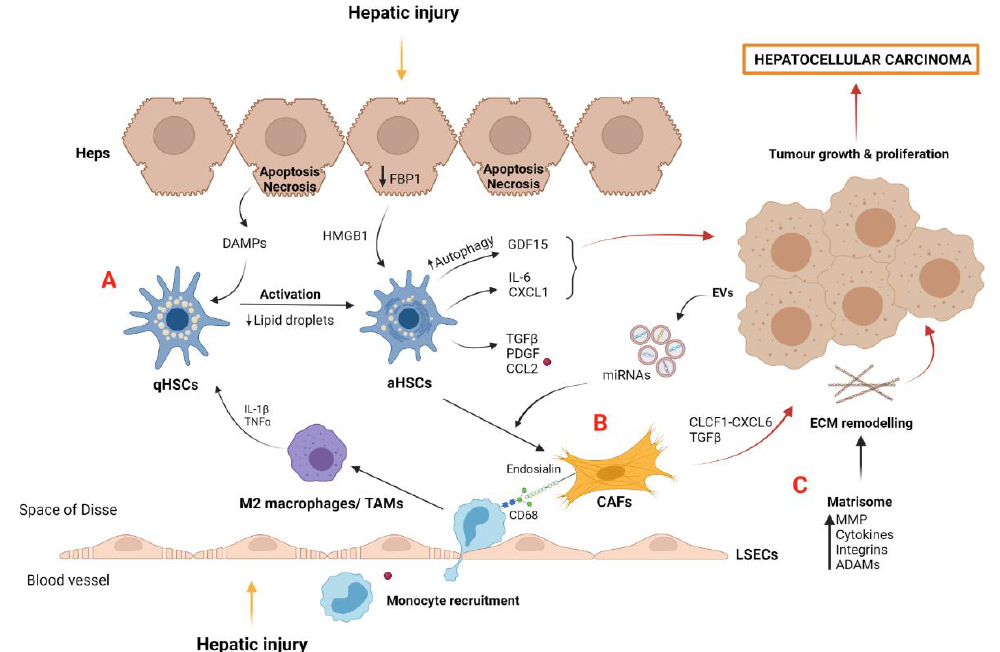
Figure 3. Myofibroblast-derived cells and matrisome contribution to tumor microenvironment and HCC development: ( A ) Quiescent HSCs become activated by DAMPs released by apoptotic hepatocytes and by IL-1 β and TNF α secreted by polarized M2 macrophages after hepatic injury. aHSCs induce the secretion of proinflammatory growth factors and chemokines such as CCL2, which is recognized by macrophage CCR2, perpetuating liver damage and tumor growth. aHSCs, induced by the loss of hepatocyte FBP1, secrete cytokines such as IL-6 and CXCL1, which are involved in liver tumorigenesis. Growth factor GDF15, induced by aHSC autophagy, also contributes to hepatocarcinoma. ( B ) CAFs are derived from activated myofibroblasts such as aHSCs. Diverse growth factors and miRNAs contained in EVs and released from cancer cells act as positive stimuli for CAF differentiation. CAFs promote tumor development via the CLCF1–CXCL6/TGF β signaling pathway and induce the recruitment of macrophages and M2 polarization by endosialin–CD68 interaction. ( C ) The matrisome plays a key role in hepatocellular carcinoma development by the action of several molecules secreted into the tumor microenvironment, such as MMP, cytokines, integrins, and ADAMs. Abbreviations: aHSCs, activated hepatic stellate cells; qHSCs, quiescent hepatic stellate cells; CAFs, cancer-associated fibroblast cells; CCL2, chemokine (C-C motif) ligand 2; CLCF1, cardiotrophin like cytokine factor 1; ECM, extracellular matrix; EVs, extracellular vesicles; Heps, hepatocytes; HGF, hepatocyte growth factor; HMGB1, high mobility group box protein 1; LSECs, liver sinusoidal endothelial cells; MMP, metalloproteinases; TAMs, tumor-associated macrophages; PDGF, platelet-derived growth factor; TAMs, tumor-associated macrophages; TGF- β , transforming growth factor beta. Created with